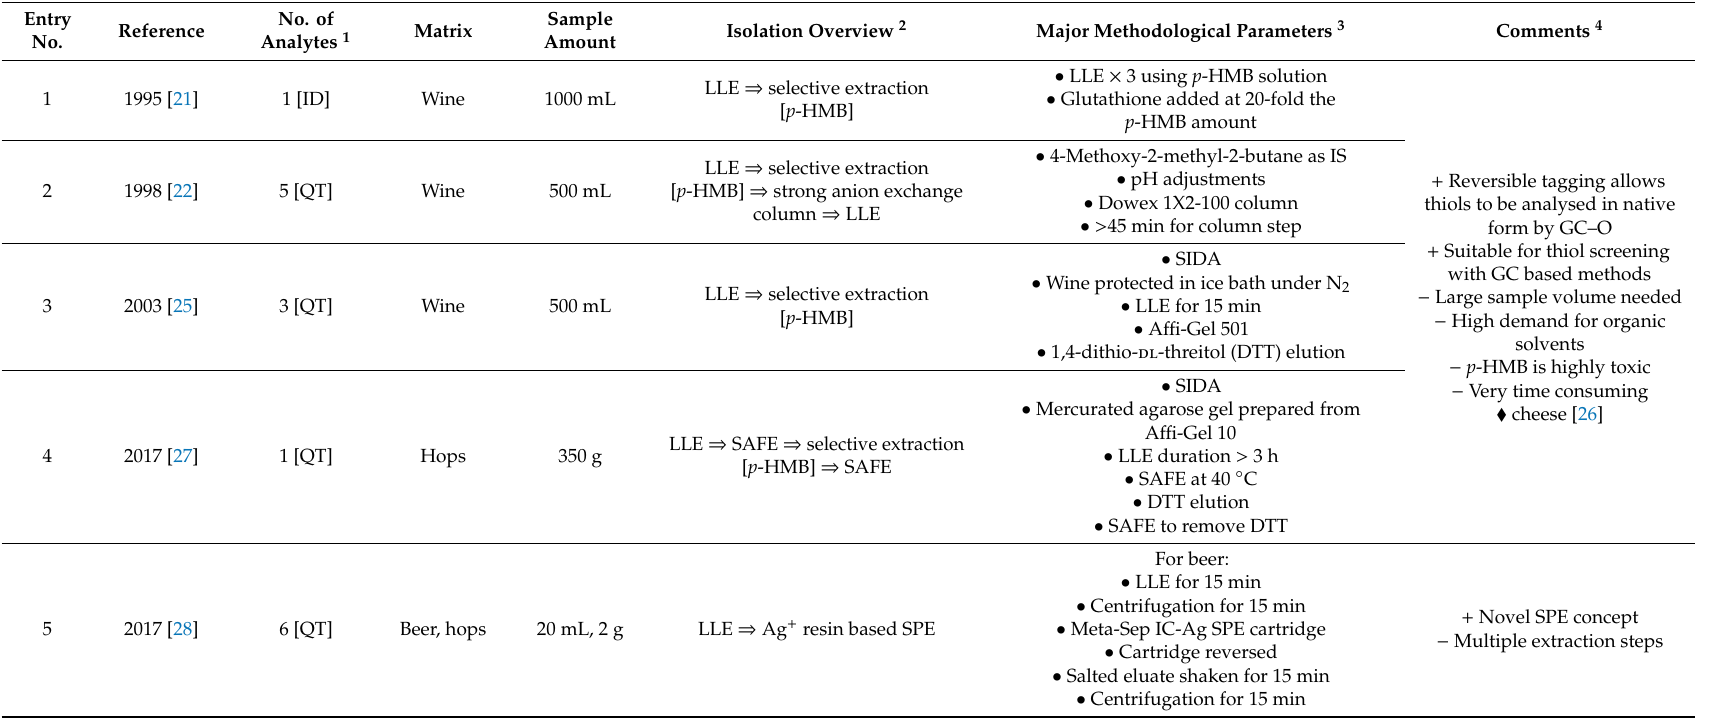
Table 1. Isolation methods developed for analysis of potent volatile thiols in wines, foods, and other beverages. Entry